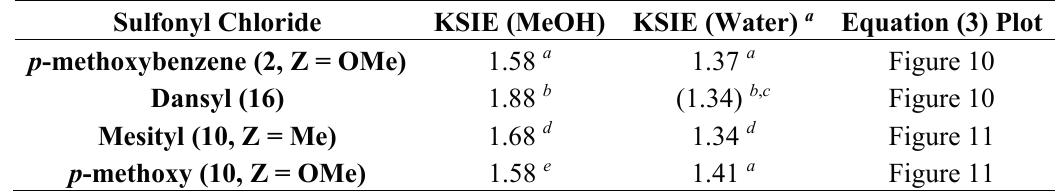
Table 4. Mechanistic changeover for solvolyses of electron-rich sulfonyl